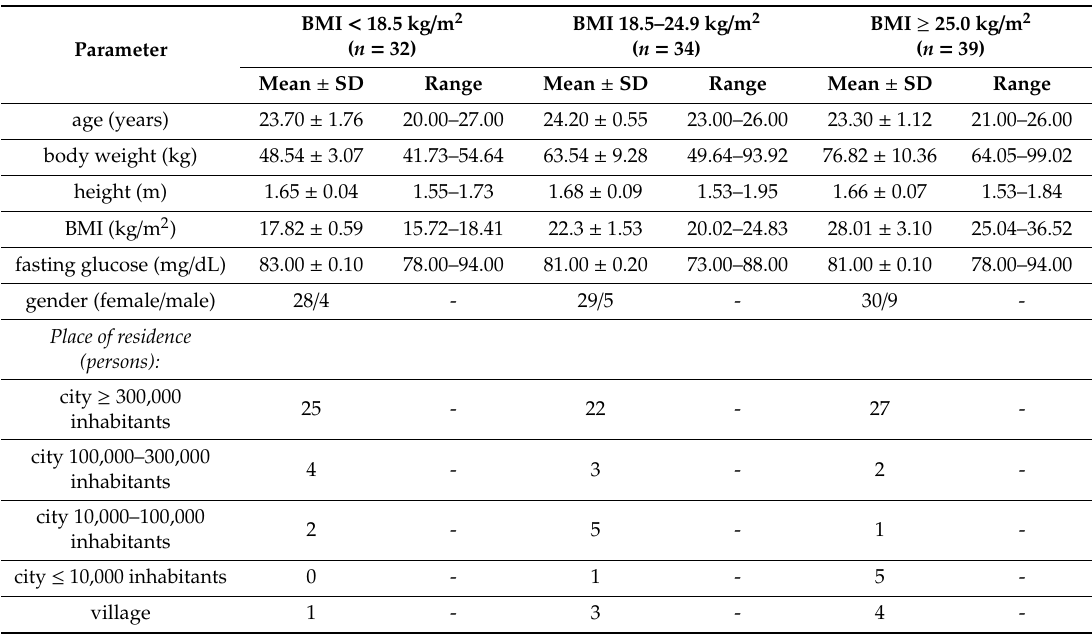
Table 1. Baseline clinical and anthropometric characteristics (mean ± standard deviations (SD) of subjects ( n = 105) involved in the study.